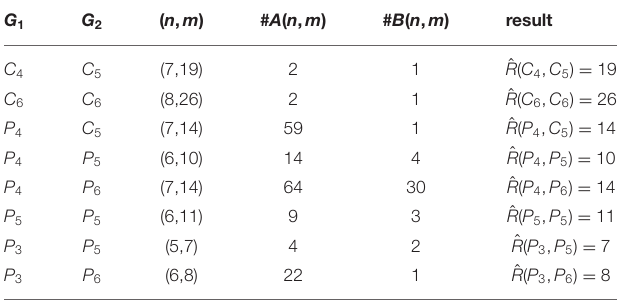
TABLE 1 | Exact values ˆ R ( G 1 , G 2 ) of the size Ramsey numbers of some paths and